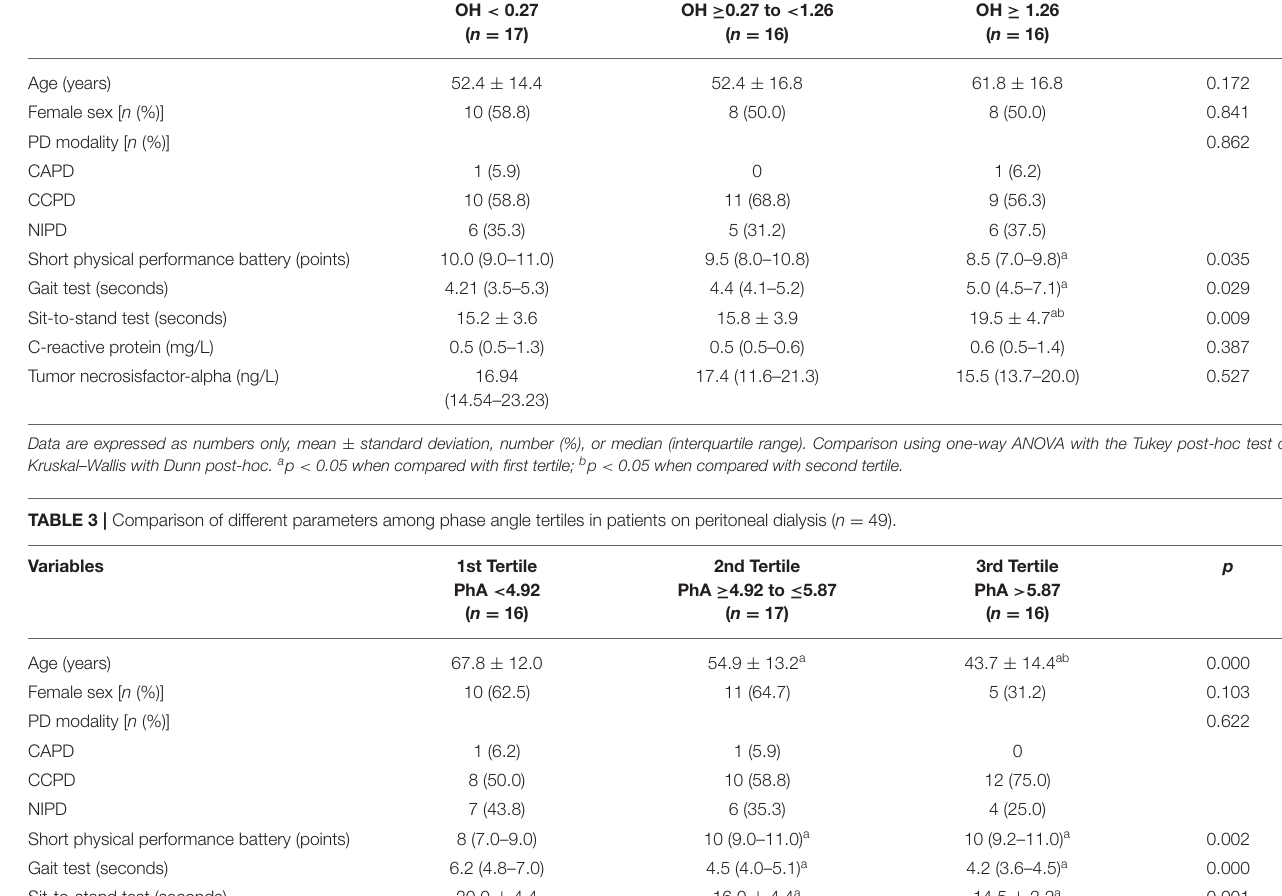
TABLE 2 | Comparison of different parameters among overhydration tertiles in patients on peritoneal dialysis ( n = 49). Variables